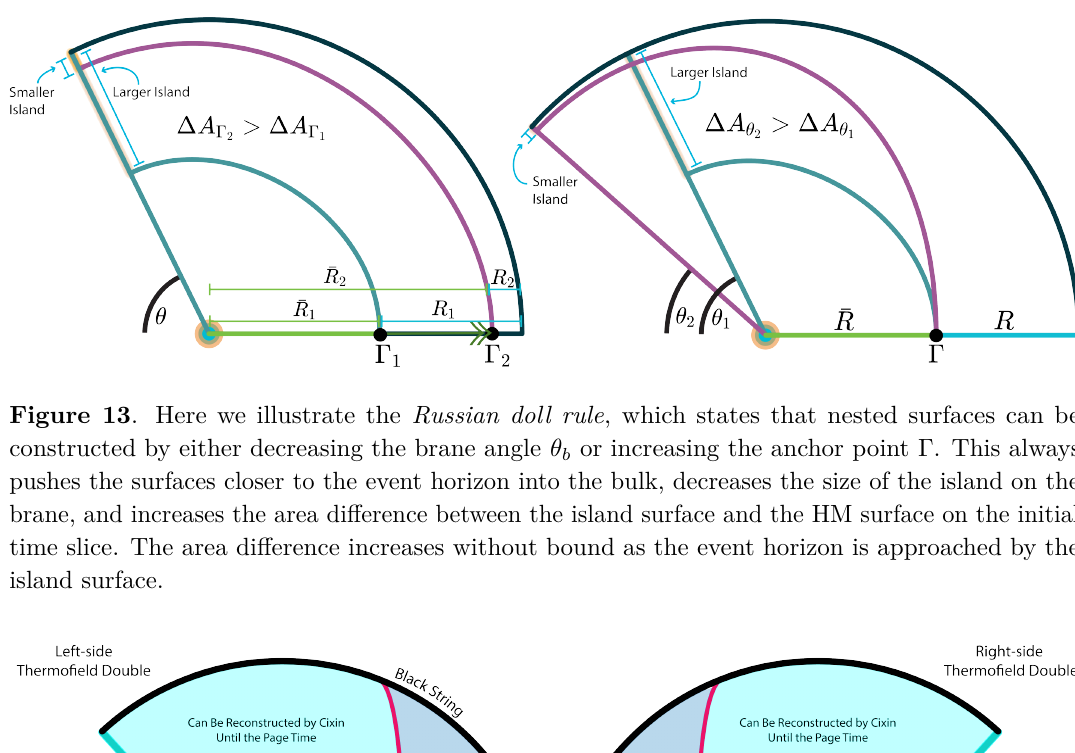
Figure 14 . The island region can be reconstructed using boundary data in are accessible and only until the Page time. According to the Russian doll rule, the size of the region which is lost at the Page time increases monotonically with the brane angle θ monotonically with Γ